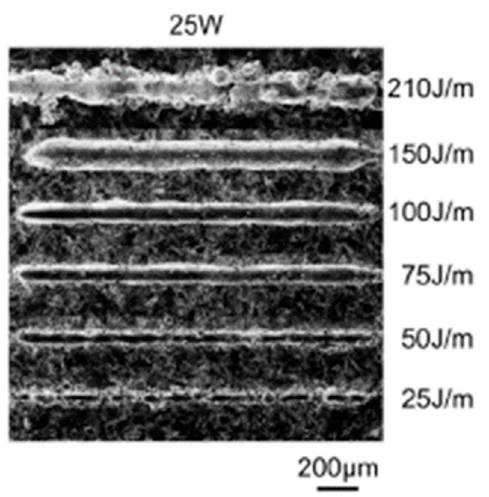
Figure 25. ( a , b ) Figures of a gear wheel fabricated at a scanning speed of 0.7 m/s, pulse energy of 1.5 µJ and 20 MHz pulse repetition rate; ( c , d ) light microscope images at different locations on the gear [60]. gear [60].